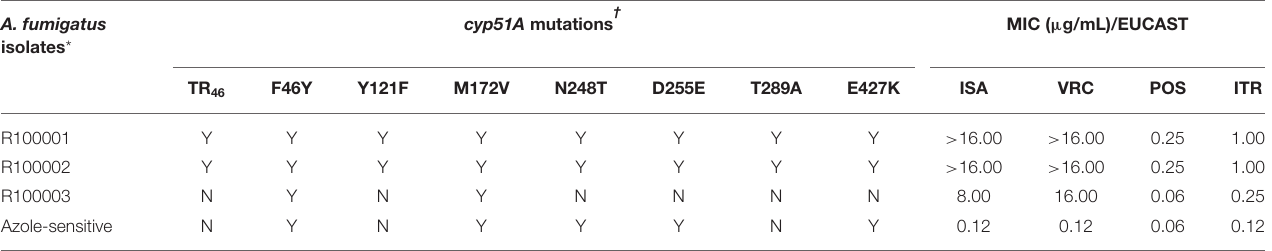
FIGURE 5 | Correlation analyses with scatter plots to compare multiple antifungal minimum inhibitory concentrations (MICs) as indicated. The significant correlation of ISA and VRC (R 2 = 0.81) was shown for Aspergillus spp. A strong correlation suggests considerable cross-resistance. (A) ISA vs VRC; (B) ISA vs POS; (C) ISA vs ITR; (D) VRC vs POS; (E) VRC vs ITR; and (F) POS vs ITR. TABLE 3 | Mutations of cyp51A gene or its coding protein and cross-resistance patterns in azole-resistant and typical wild-type Aspergillus fumigatus